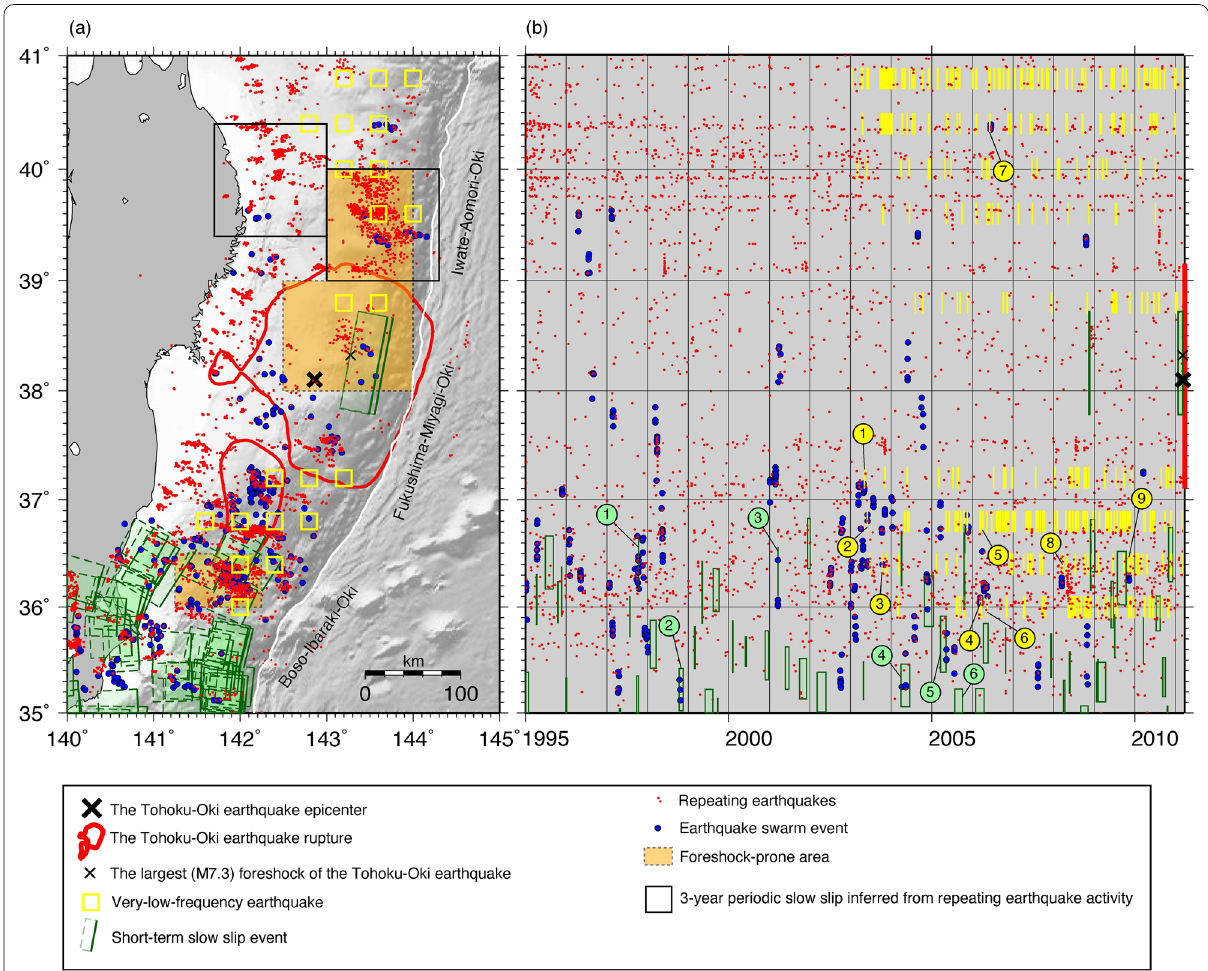
Fig. 7 Activity of repeating earthquakes and earthquake swarms along the Japan Trench before the 2011 Tohoku-Oki earthquake. a Epicenters of the repeating earthquakes and earthquake swarm events. b Spatiotemporal distribution of the repeating earthquakes and earthquake swarm events before the March 2011 Tohoku-Oki earthquake. Coincident events of SSEs and earthquake swarms are indicated by numbers 1–6 encircled in green. Coincident events of VLFEs and earthquake swarms are indicated by numbers 1–9 encircled in yellow. For an explanation of the other symbols, refer to the legend in the figure. The epicenter of the Tohoku-Oki earthquake and its largest foreshock are from the JMA catalog. The coseismic slip of the Tohoku-Oki earthquake (10 m or larger) is based on Iinuma et al. (2012). The VLFEs are from Baba et al. (2020). The short-term SSEs are from Ito et al. (2013) and Nishimura (2021). The repeating earthquakes are from Uchida and Matsuzawa (2013). The earthquake swarms ( M j 3) are from Nishikawa and Ide (2018) and Nishikawa et al. (2019). The foreshock-prone areas are based on Maeda and Hirose (2016) and Hirose ≥ et al. (2021). The 3 years periodic slow slip in the northern Japan Trench is from Uchida et al.